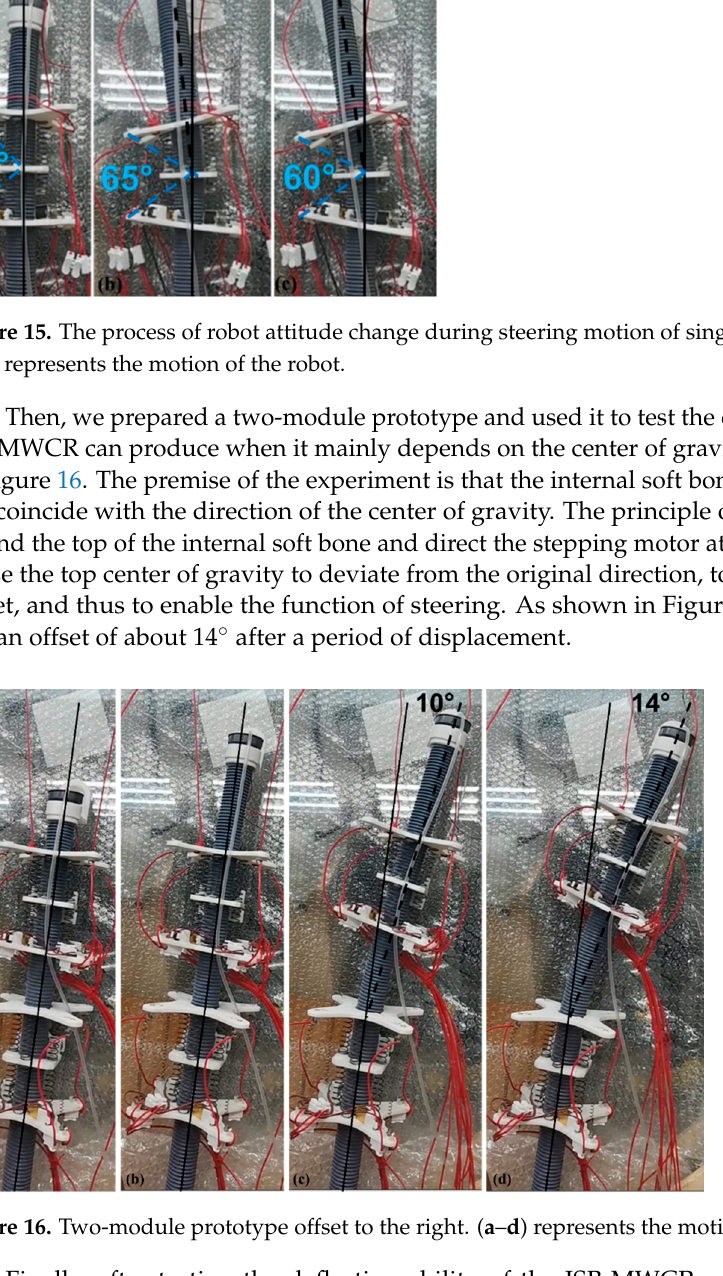
Figure 17. Two-module prototype used for tilt correction. ( a – e ) represents the motion of the robot. 3.3.3. Load Experiment Load capacity is an important performance index of wall-climbing robots. Therefore, this study first conducts a load test with a total weight of 450 g on the two-module proto- type of ISB-MWCR, as shown in Figure 18. The total weight of the two-module prototype is about 700 g (excluding the wires connecting the robot); the weight of a single module is about 300 g, and the weight of the internal soft bone is about 100 g. In this experiment, (1)